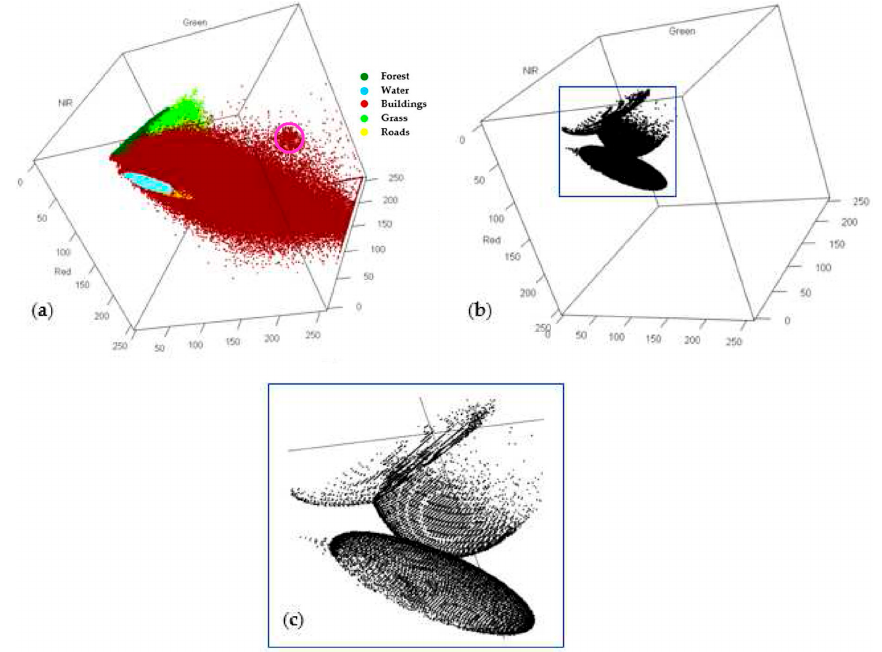
Figure 14. Three-dimensional scatterplots showing: ( a ) pixels assigned to individual LULC classes (excluding unclassified pixels) through reclassification; ( b ) unclassified pixels identified using the equal-likelihood technique with p c = 0.05; and ( c ) details of the blue box in ( b ). Pixels of the Beitou Depot of the Taipei MRT (purple-circled area) were classified into the buildings class.